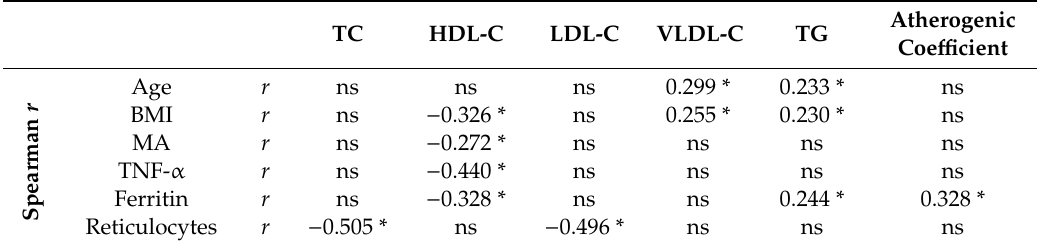
Table 7. Correlations between lipid profile, inflammatory markers and parameters of iron metabolism in patients with type 2 DM.